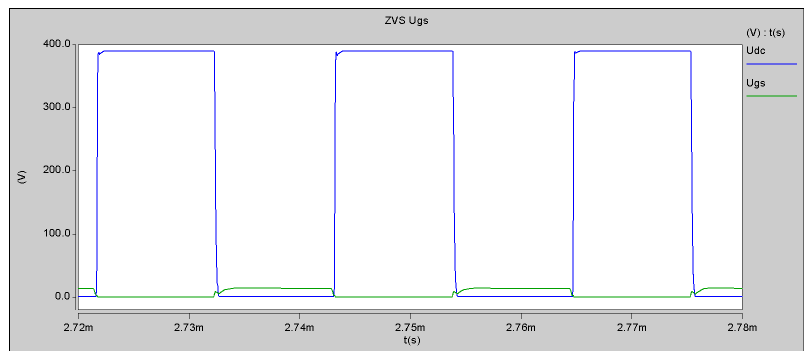
Figure 17. The drain-source voltage and driving voltage of transistor Q1.